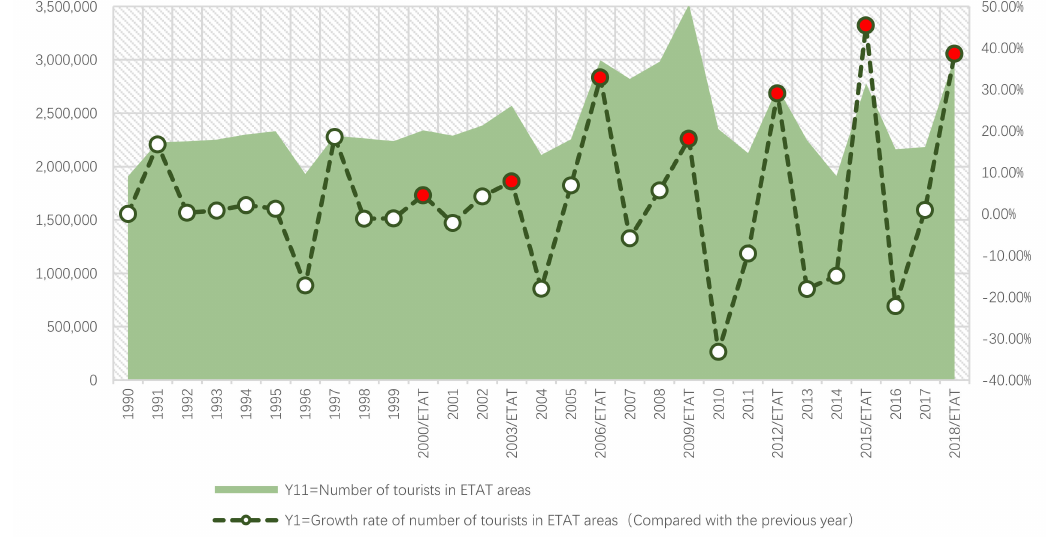
Figure 7. Tourist number and its growth rate in ETAT areas (1990–2018). Note: The red dots in the chart show that the annual growth rate increased (the hosting year of the ETAT).